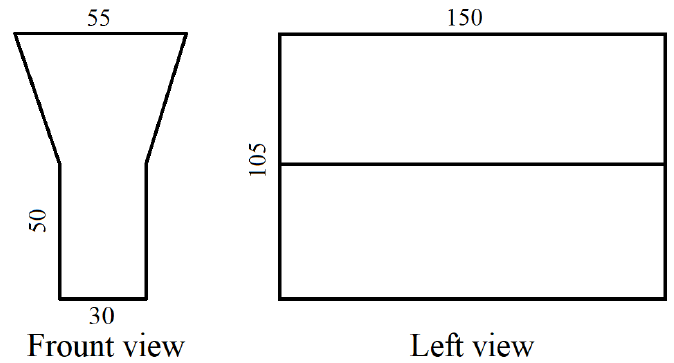
Figure 1. Shape and size of mold cavity (mm).